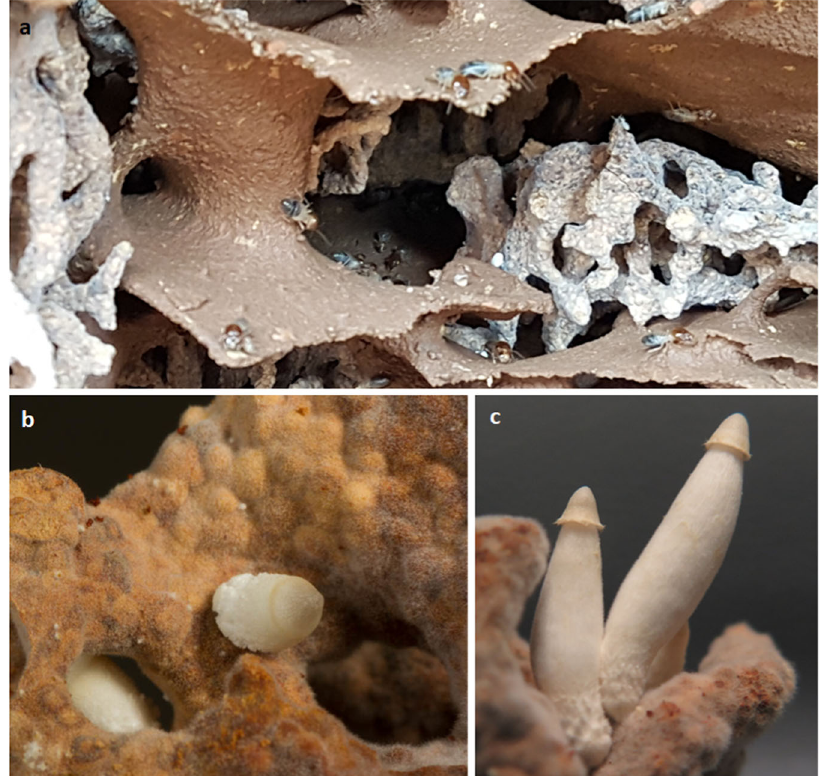
Fig. 1 Fungus comb environment of a Macrotermes natalensis colony. a Underground fungus garden chambers in which the fungus comb is maintained by grooming termite workers. b Differentiated pointy nodule of Termitomyces (Termitomyces cryptogamus ). c Young mushroom developing from pointy nodules after 3